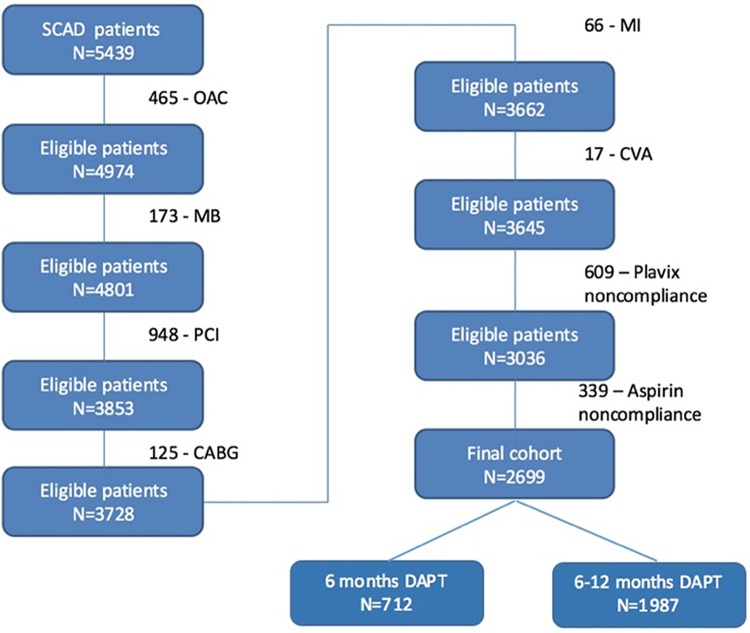
Cohort selection process.Reasons for exclusion of patients from study: CABG = coronary artery bypass graft surgery, CVA = cerebrovascular accident, MB = major bleeding, MI = myocardial infarction, OAC = oral anticoagulation, PCI = percutaneous coronary intervention. Other abbreviations: SCAD = stable coronary artery disease, DAPT = dual antiplatelet therapy.